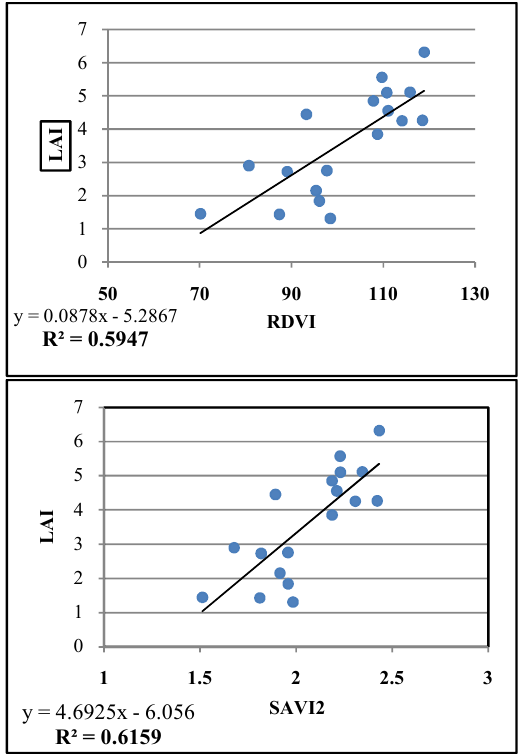
Figure 3. SAVI2 and RDVI relations with LAI In red region of Electromagnetic spectrum, due to absorption of